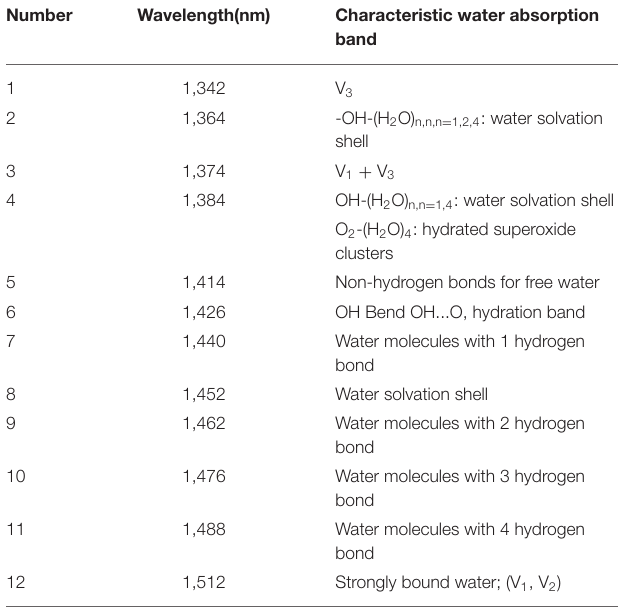
TABLE 2 | Water matrix coordinates: characteristic absorption of water in NIR spectra (32–39).